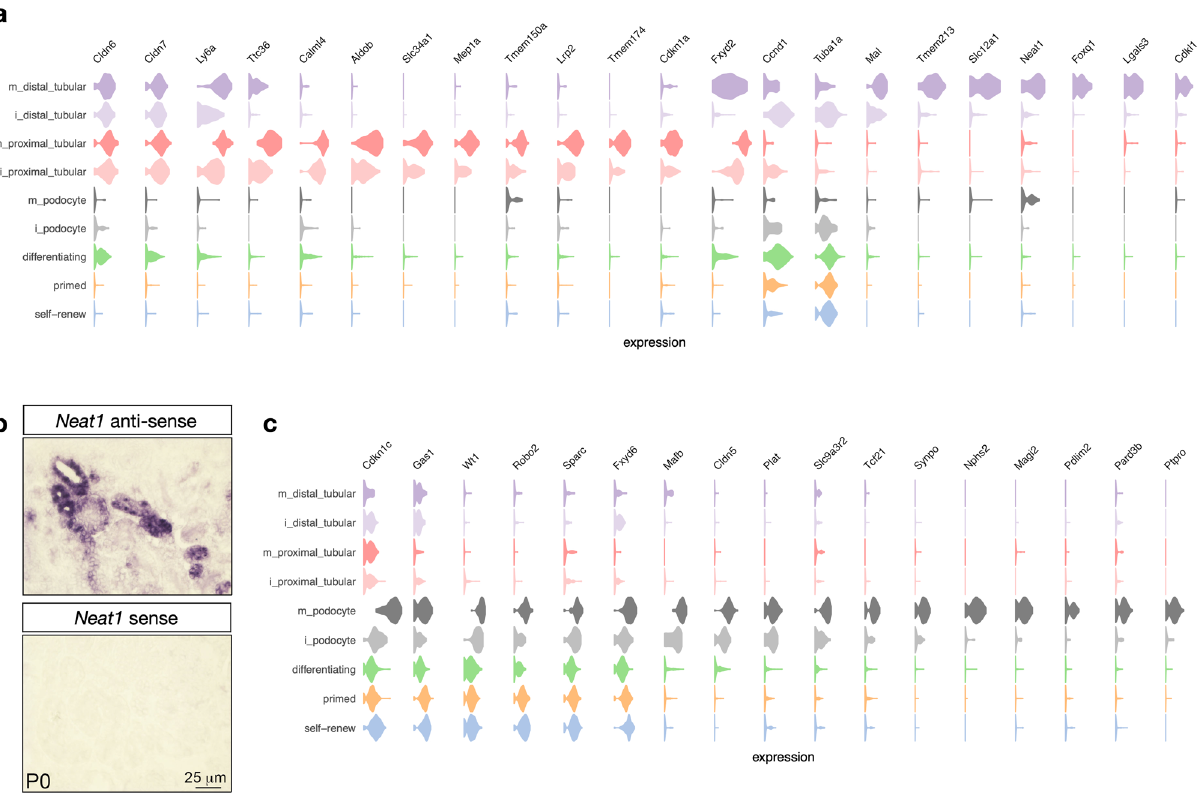
Figure 4. Transcriptional signatures of podocytes and tubular cells. (a) Violin plot of genes expressed in proximal and distal tubular cells (rows are clusters and columns denote genes). (b) In situ hybridization of P0 kidneys confirms expression of Neat1 in distal tubules. No signal was detected with sense probe hybridization. (c) Same as (a) , but for podocytes.